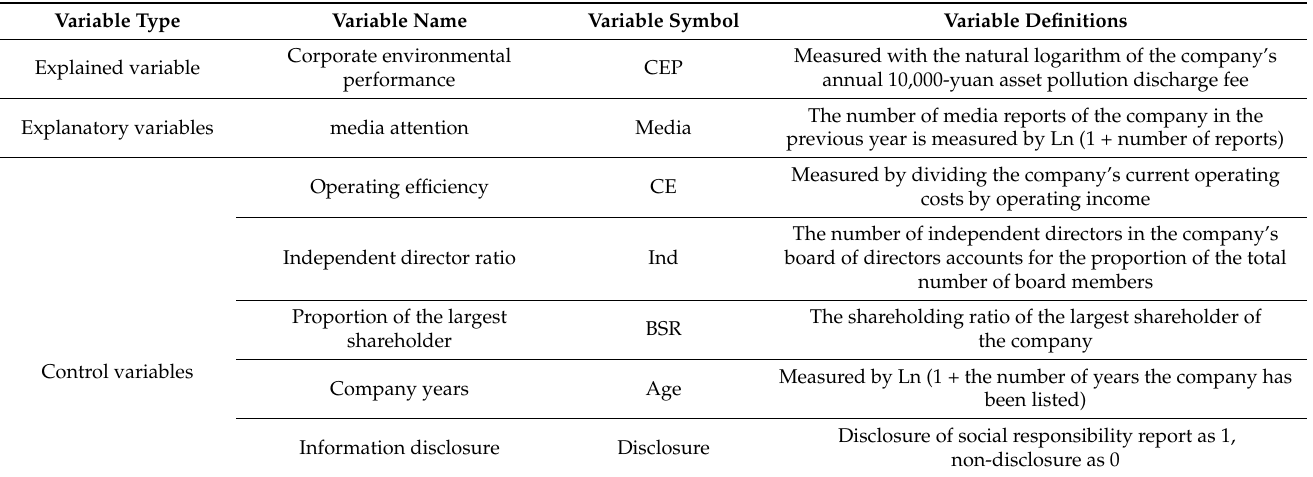
Table 1. Variable definition